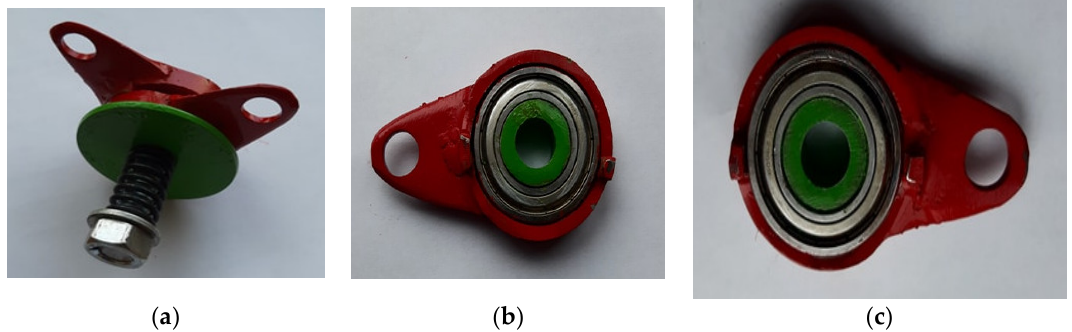
Figure 11. Designed elbow joint of the anthropometric dummy: ( a ) view of the entire joint, ( b ) view of the right part of the joint, ( c ) view of the left part of the joint.